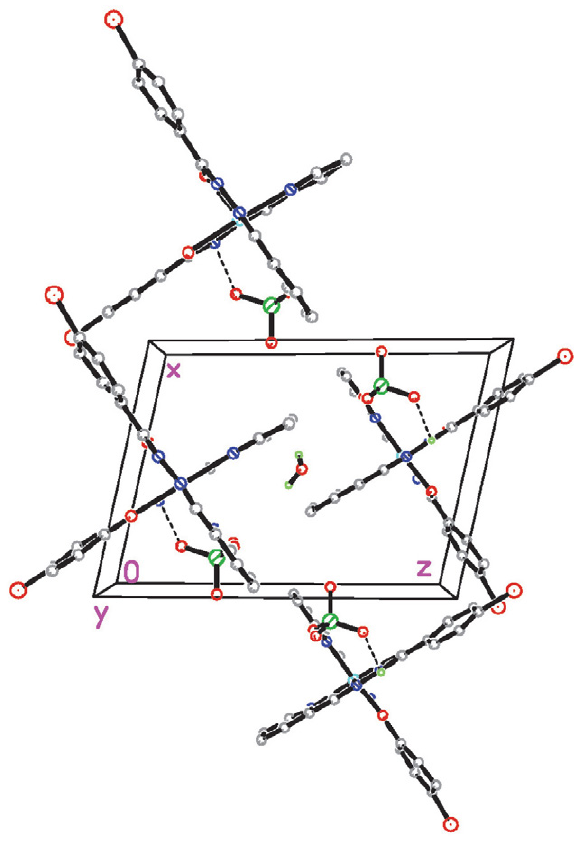
Fig. 4. Molecular packing structure of complex 2 linked by hydro- gen bonds.